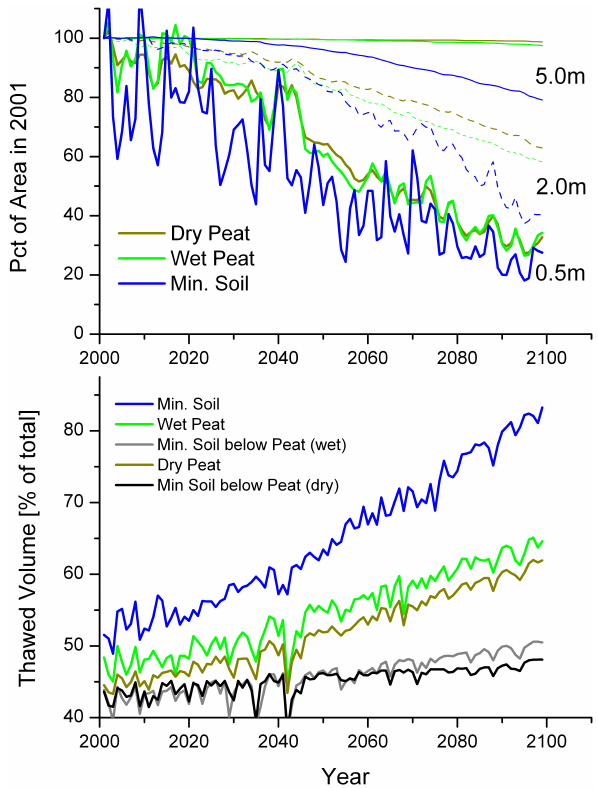
Fig. 6. Areas underlain by permafrost at different depth for dry and wet peat and mineral soil relative to 2001 (top; see Table 5 for ab- solute values) and time series of thawed soil volume as percentage of the total volumes (bottom; see Table 6 for absolute